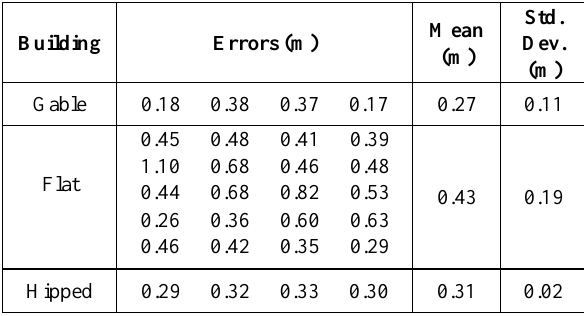
Table 1. Quantitative